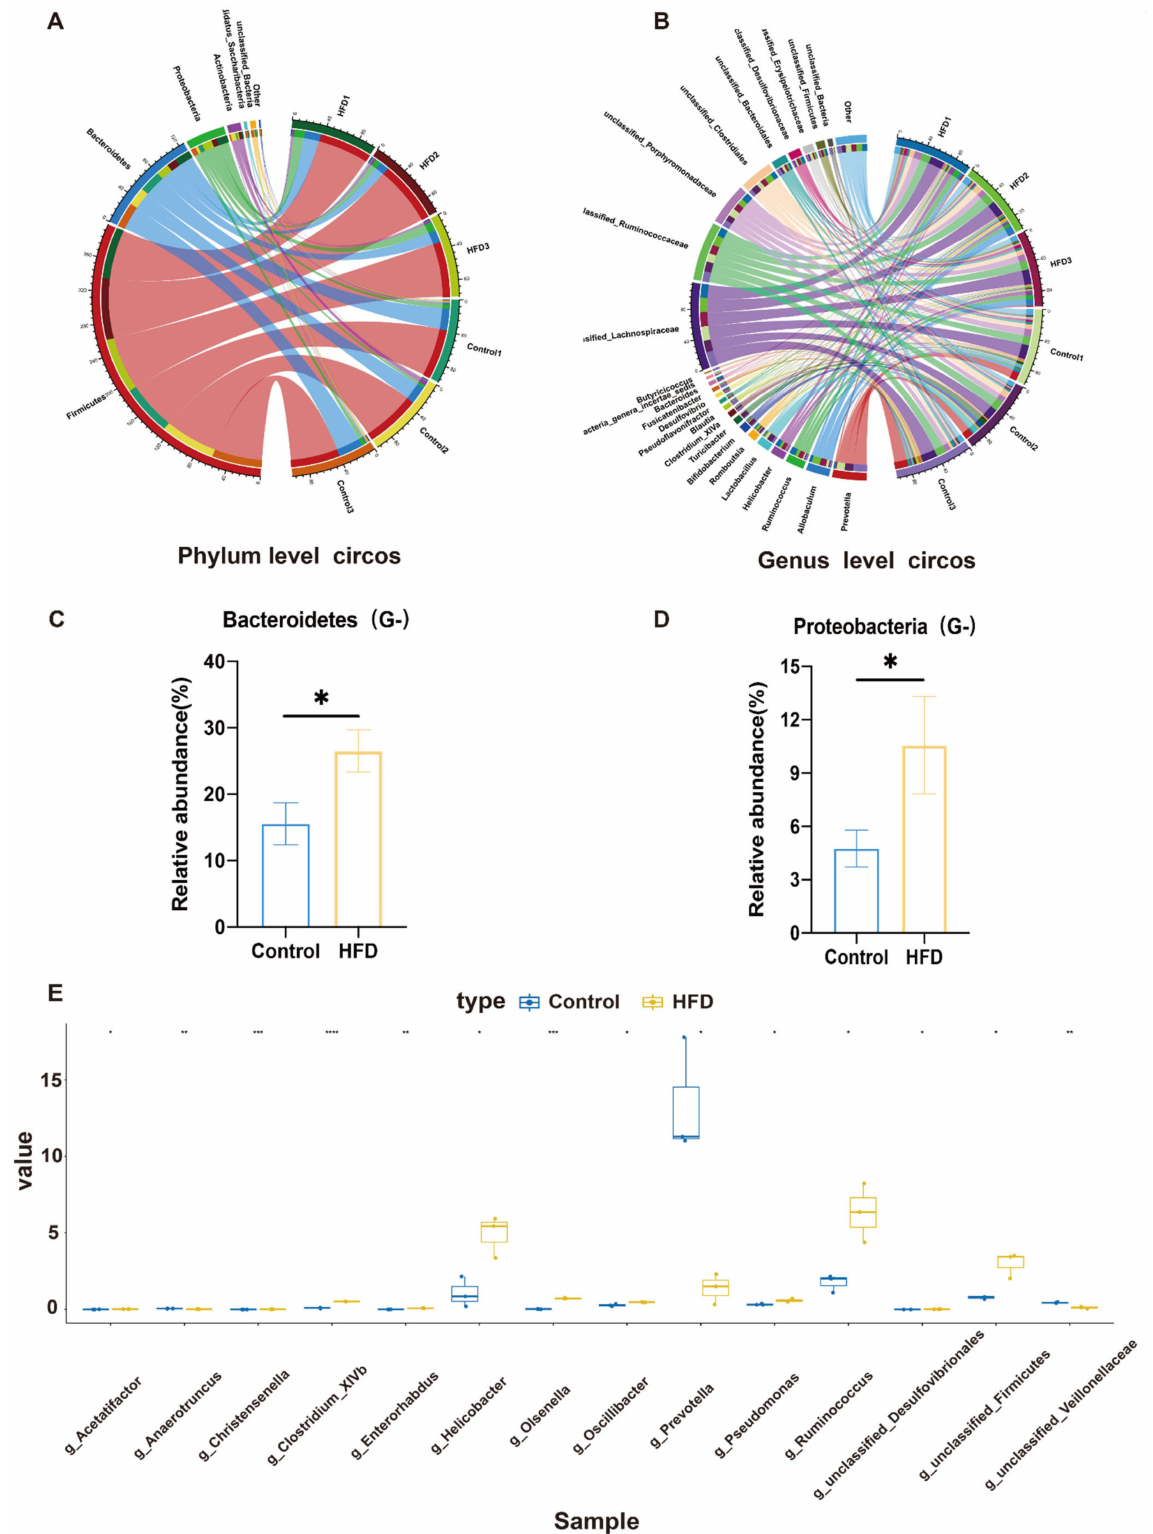
Figure 4. Overview of faecal flora distribution in rats after HFD treatment for eight